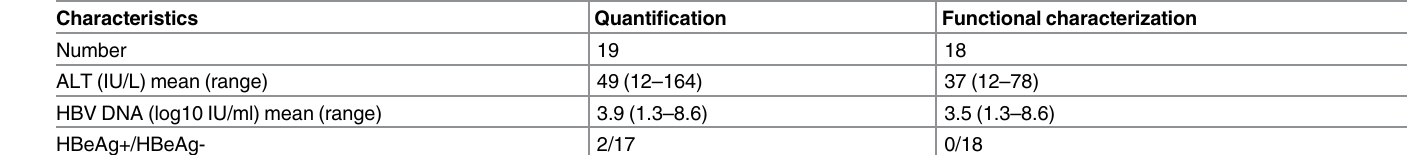
Table 1. Characteristics of donors used for peripheral blood DC quantification and functional characterization.